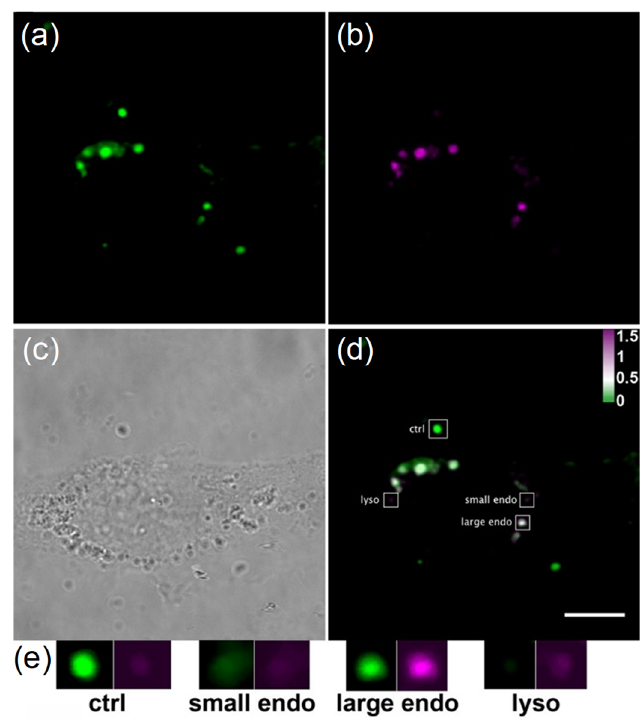
Figure 4. Ratiometric imaging of pH probes reveals their localization in three types of microenvironment. ( a ) Localization of UCNPs detected using 980 nm excitation, ( b ) sensitized upconversion resonance energy transfer emission from pHrodo Red, ( c ) bright-field, ( d ) an overlaid ratiometric image of pH nanoprobes with different ratios depending on the localization. Scale bar 10 µ m. The enlarged insets ( e ) show different ratios in extracellular (ctrl), small endosome, large endosome, and lysosome. Brightness of insets is increased by 10 gray level units from the overlaid image ( d ) for better visibility [98]. Reprinted from [98] with permission from American Chemical Society. Copyright 2017 American Chemical Society.